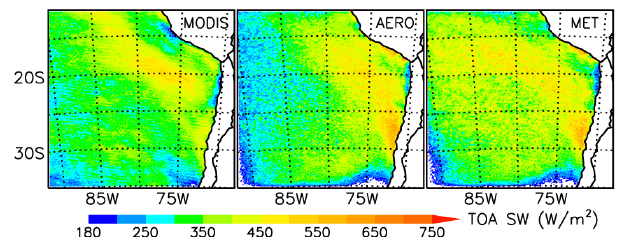
Fig. 10. Top-the-atmosphere (TOA) outgoing shortwave (SW) ra- diation fluxes measured by the CERES (Terra) and those simulated in the AERO and MET